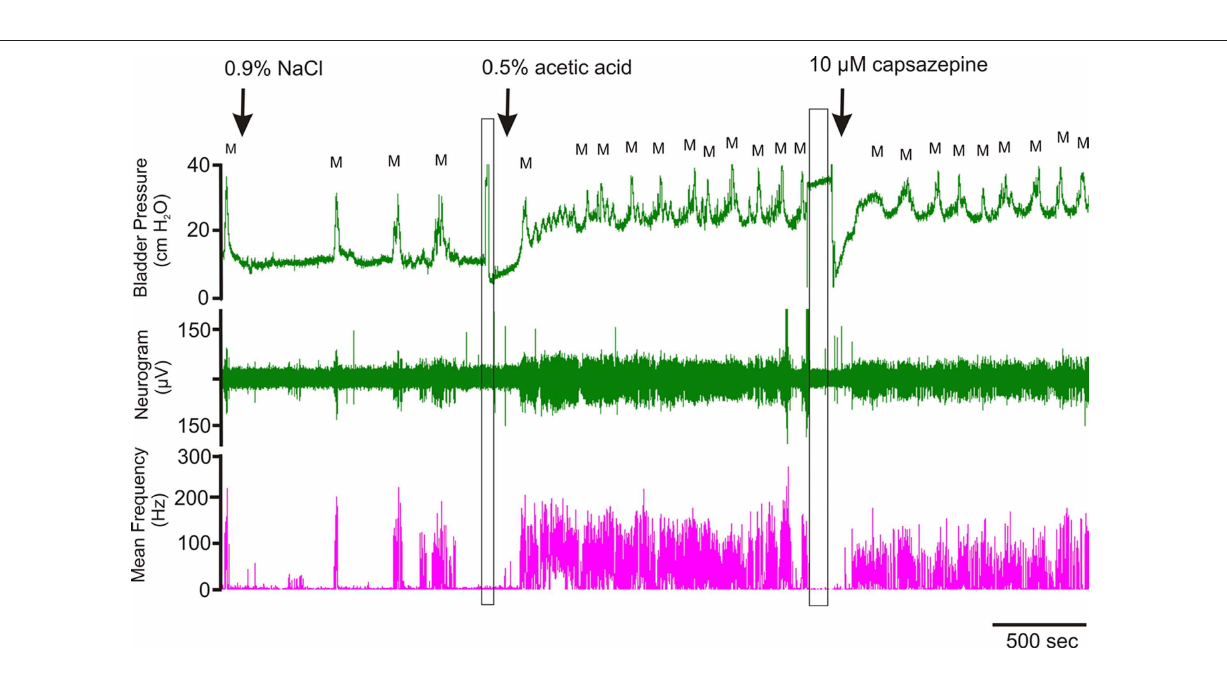
Figure 3 | Continuous recording of bladder pressure and afferent nerve activity. Infusion of 0.9% NaCl led to regular micturition cycles with steady pressure during filling. 0.5% acetic acid led to higher micturition frequency, multiple non-voiding contractions along with elevated filling, threshold and micturition